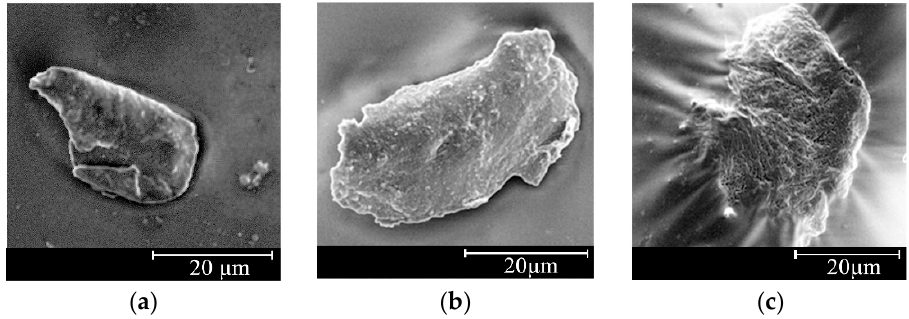
( c ) Figure 5. Micro surface texture morphologies of the mineral filler particles. ( a ) Granite filler (5000×) ; ( b ) Diabase filler (3000×) ; ( c ) Limestone filler (2500×) . The adhesion ability between the asphalt binder and filler was also reflected by the interfacial tension state to some extent. The interfacial micrographs obtained using an SEM for LAM, DAM, and GAM in the case of an F/A ratio of 1.0 are shown in Figure 6. As illustrated in Figure 6c, the limestone filler particles were completely immersed in the asphalt binder with an indistinct boundary between the asphalt binder and the limestone filler particles exhibited a wrinkled condition, which indicates that the asphalt binder could provide a better adhesion effect on the limestone filler particles due to the powerful polar absorption ability. Regarding DAM and GAM, a distinct boundary between the asphalt binder and filler particles was observed and there existed an isolated envelope line between them, which indicated that although the asphalt binder provided the wrapping effect on the filler particles, the interfacial bonding interaction between them was weaker than that of LAM. Furthermore, the SSA of the mineral filler is an important parameter influencing the asphalt–filler